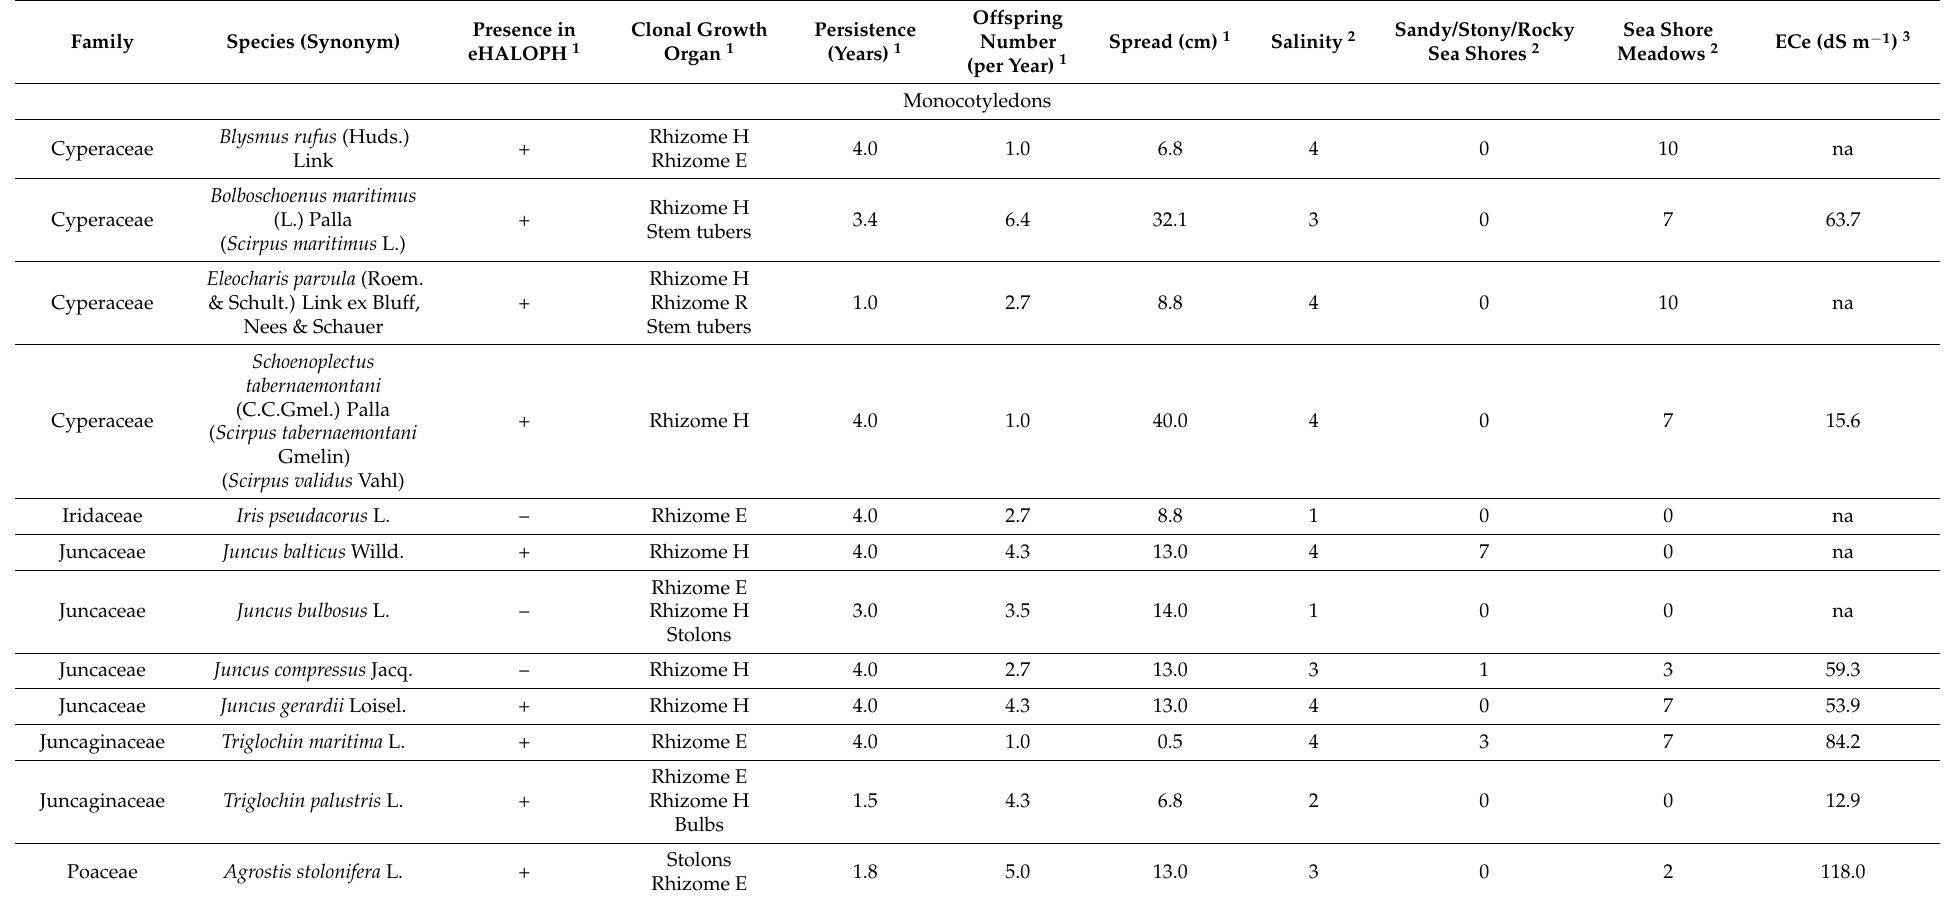
Table 1. The list of potential clonal halophyte plant species of the Baltic Sea